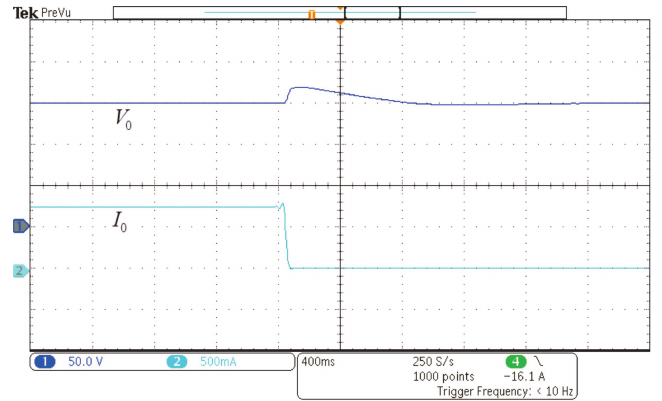
Figure 22. PWM rectifier transient from high-load to no-load. DC-link voltage (50 V/div) and dc-link current (2 A/div). V grms = 21 V. Hor 0.4